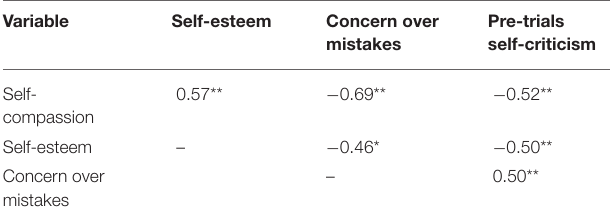
TABLE 3 | One-tailed Pearson correlations before receiving feedback for Phase II participants.